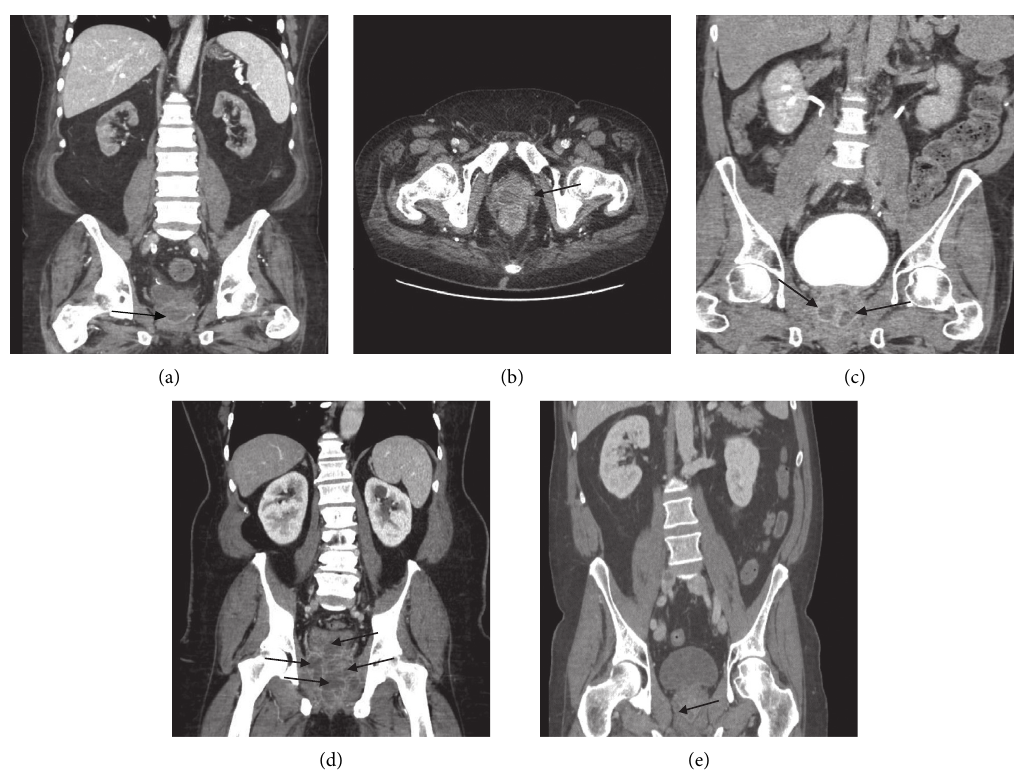
Figure 1: (a) Patient 1 had hypoattenuating lesions within the prostate consistent with multiple prostate abscesses; (b) patient 2 had a 2.4cm prostatic abscess; (c) patient 3 had 2 low attenuation fluid collections within the prostate, measuring 2.6 × 1.4cm on the right and 1.9 × 1.1cm on the left; (d) patient 4 had a 7.8 × 7.6 × 10cm multiloculated fluid collection with peripheral enhancement consistent with prostatic abscess; (e) patient 5 had a 2 cm prostate